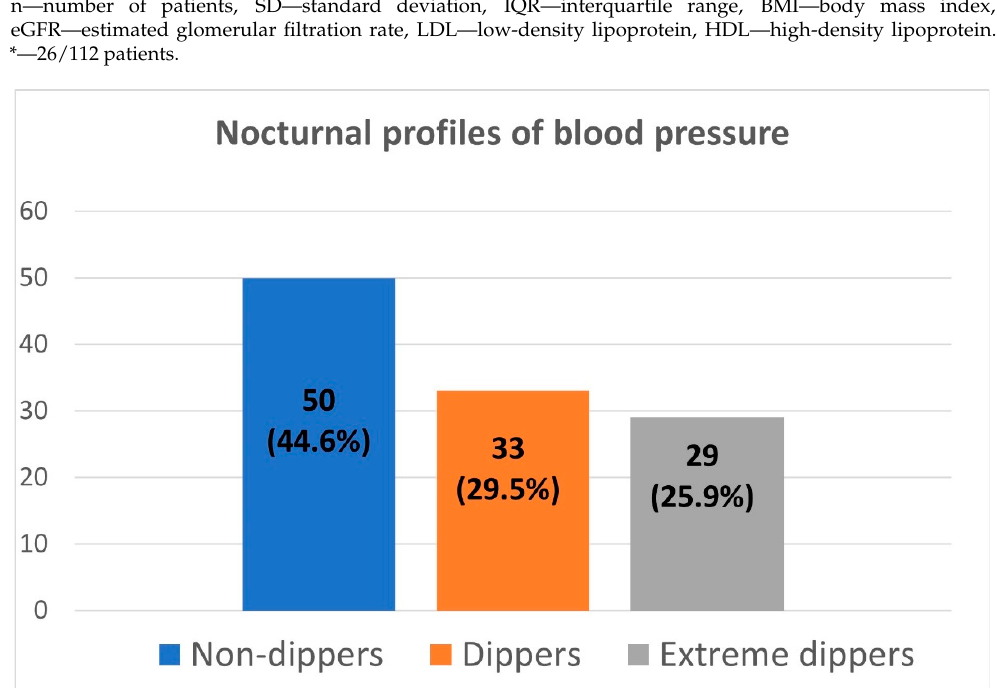
Table 4. Hypertension-mediated organ damage in the studied children.